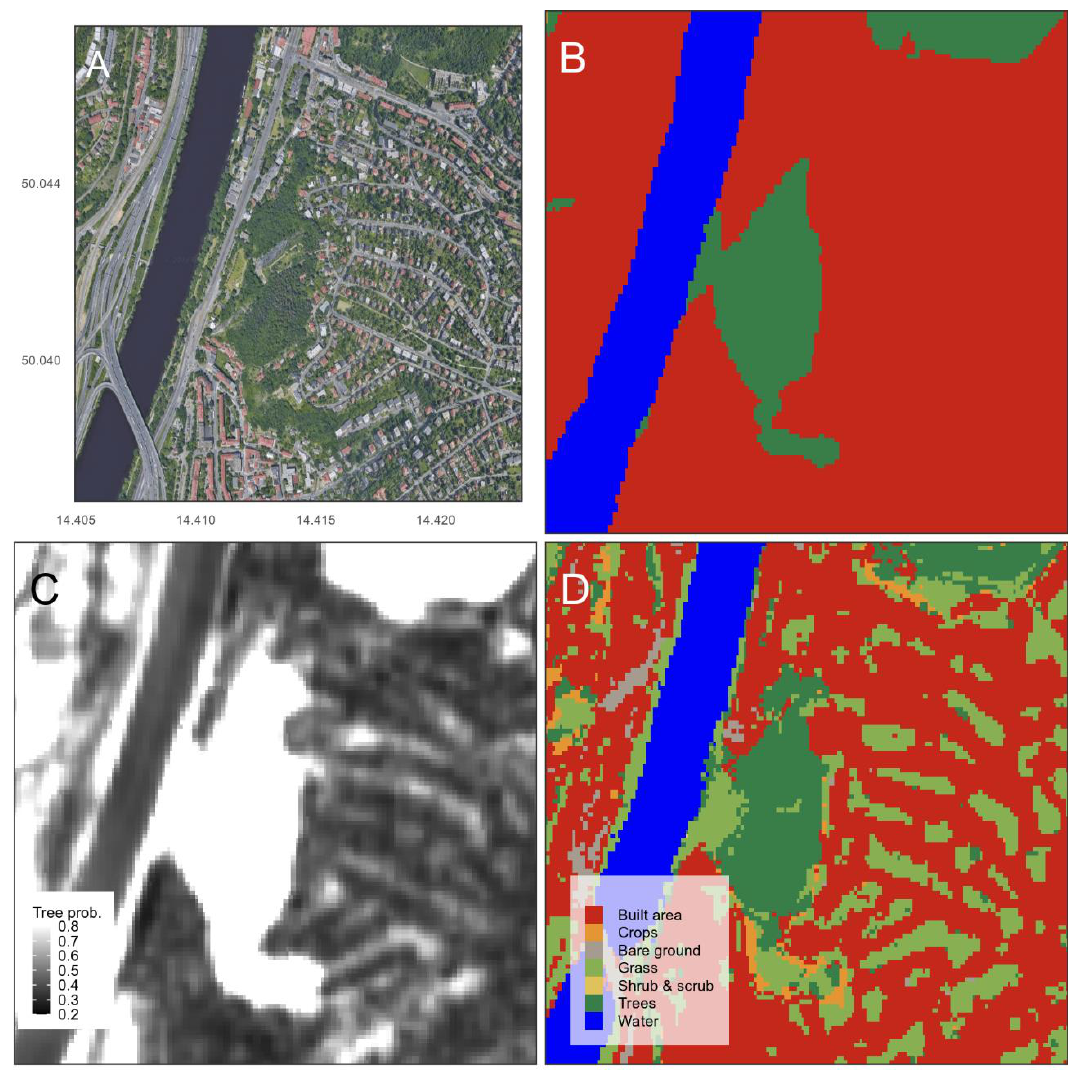
Figure 8. Example of the flexibility inherent in the Dynamic World data format, which includes multi-temporal class probability estimates. An urban landscape in Prague, Czechia ( A ) along with an annual mode composite from Dynamic World ( B ). Dynamic World class probabilities for the tree class are rescaled to highlight intra-urban tree cover ( C ). The predictions from a random forest model trained on LUCAS reference data and Dynamic World class probabilities are shown in ( D ), illustrating the possibility of resolving smaller landscape elements.